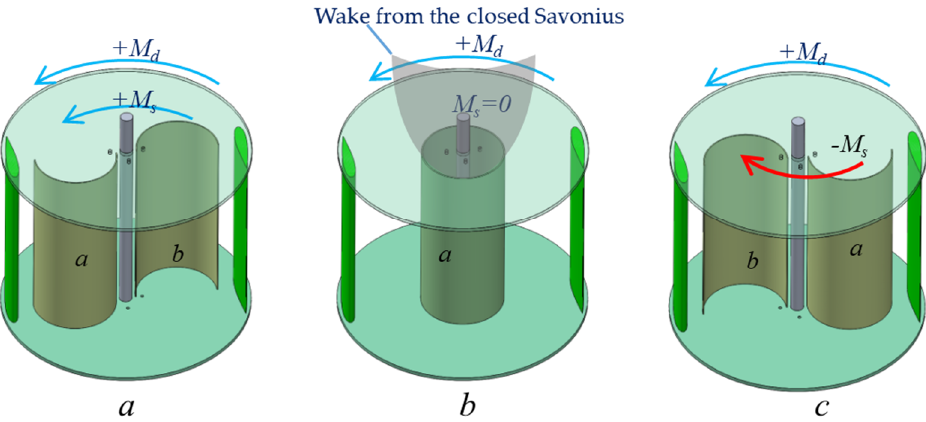
Figure 1. ( a ) Adaptive Hybrid Darrieus Turbine (AHDT) rotor in open configuration ( b ) Closed configuration ( c ) Braking configuration.